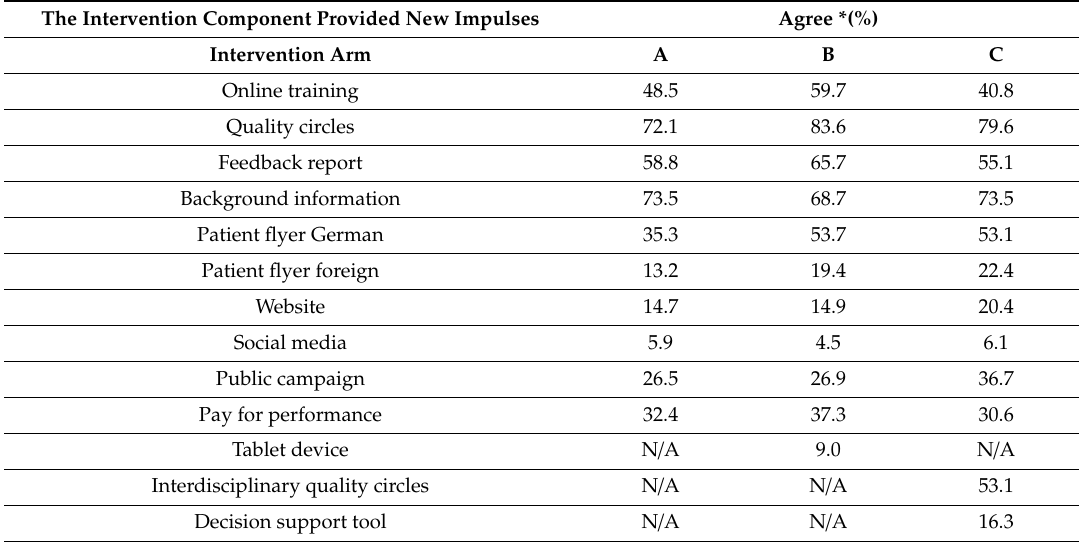
Table 4. Physician perspective on new impulses provided by study components (T2, n =